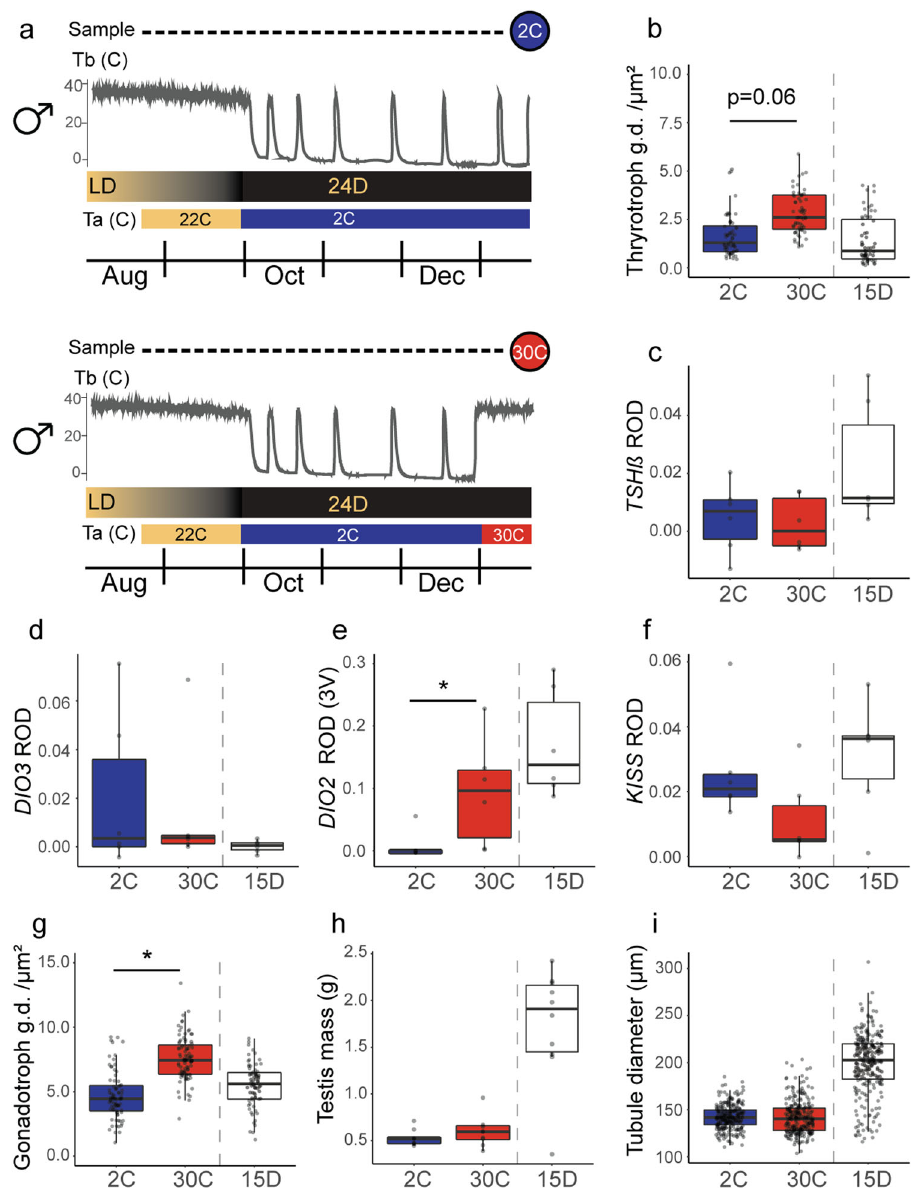
Fig. 6 Mid-hibernation warming alters TH signaling. a Schematic of experiment testing effects of two-week mid-hibernation warming on activation of TH signaling pathways and the reproductive axis. Filled circles represent the sampling timepoints for control animals sampled at an environmental temperature of 2 °C (top) and experimentally warmed animals sampled at a temperature of 30 °C (bottom). Thin gray lines present expected changes in body temperature across hibernation under temperature treatments; temperature traces are a schematic. The top-colored bar indicates the photoperiodic regime experienced by study subjects (LD = long day, 24D = continuous darkness). The lower colored bar indicates the hibernaculum temperature. Panels b – i present results for control (blue) and experimentally warmed (red) animals. The center line in the box plot represents the median, box boundaries represent the 25th and 75th percentiles, and error bars represent the 25th and 75th percentiles ± 1.5 times the interquartile range. An additional boxplot (white) shows results for animals 15 days post-hibernation (15D; from the preceding repeated cross-sectional study). Stars indicate signi fi cant differences between control and experimental animals ( p < 0.05) using a linear mixed effects model. For sample sizes, see “ Methods ” . See also Supplementary Fig. termination have been understudied in females, we found chan- ges in retrograde TH signaling were ampli fi ed in this sex. Field data indicate that reproductive females end hibernation earlier than non-reproductive animals 31 , which is consistent with the limited data indicating estradiol and progesterone may alter the expression of torpor in hibernators 52 . Thus, T3-induced activa- tion of the reproductive axis is likely critical for driving sex- differences in spring hibernation phenology.